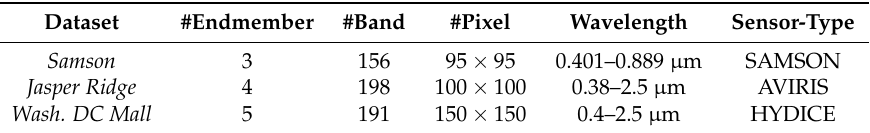
Table 1. Characteristics of three real hyperspectral image datasets.